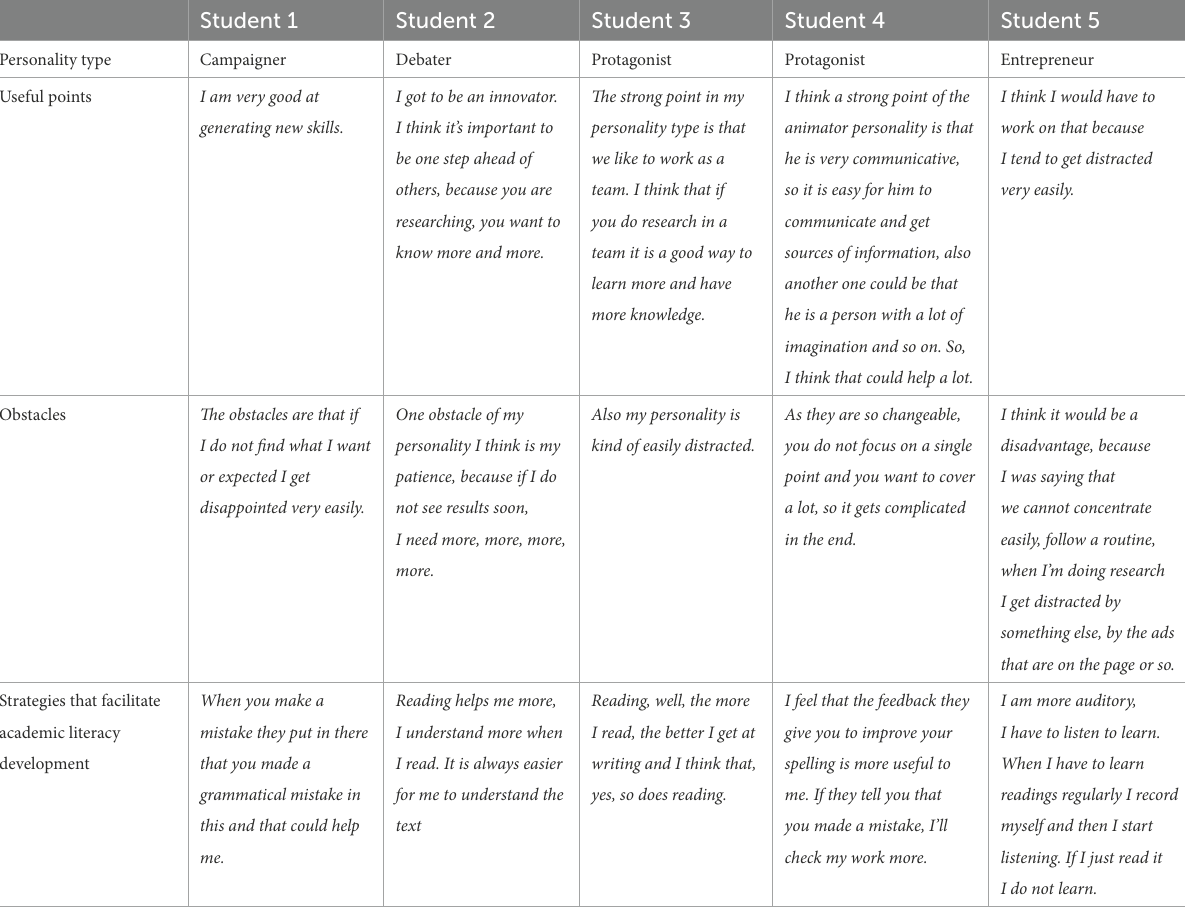
TABLE 6 Helpful and hindering points in the development of academic literacy